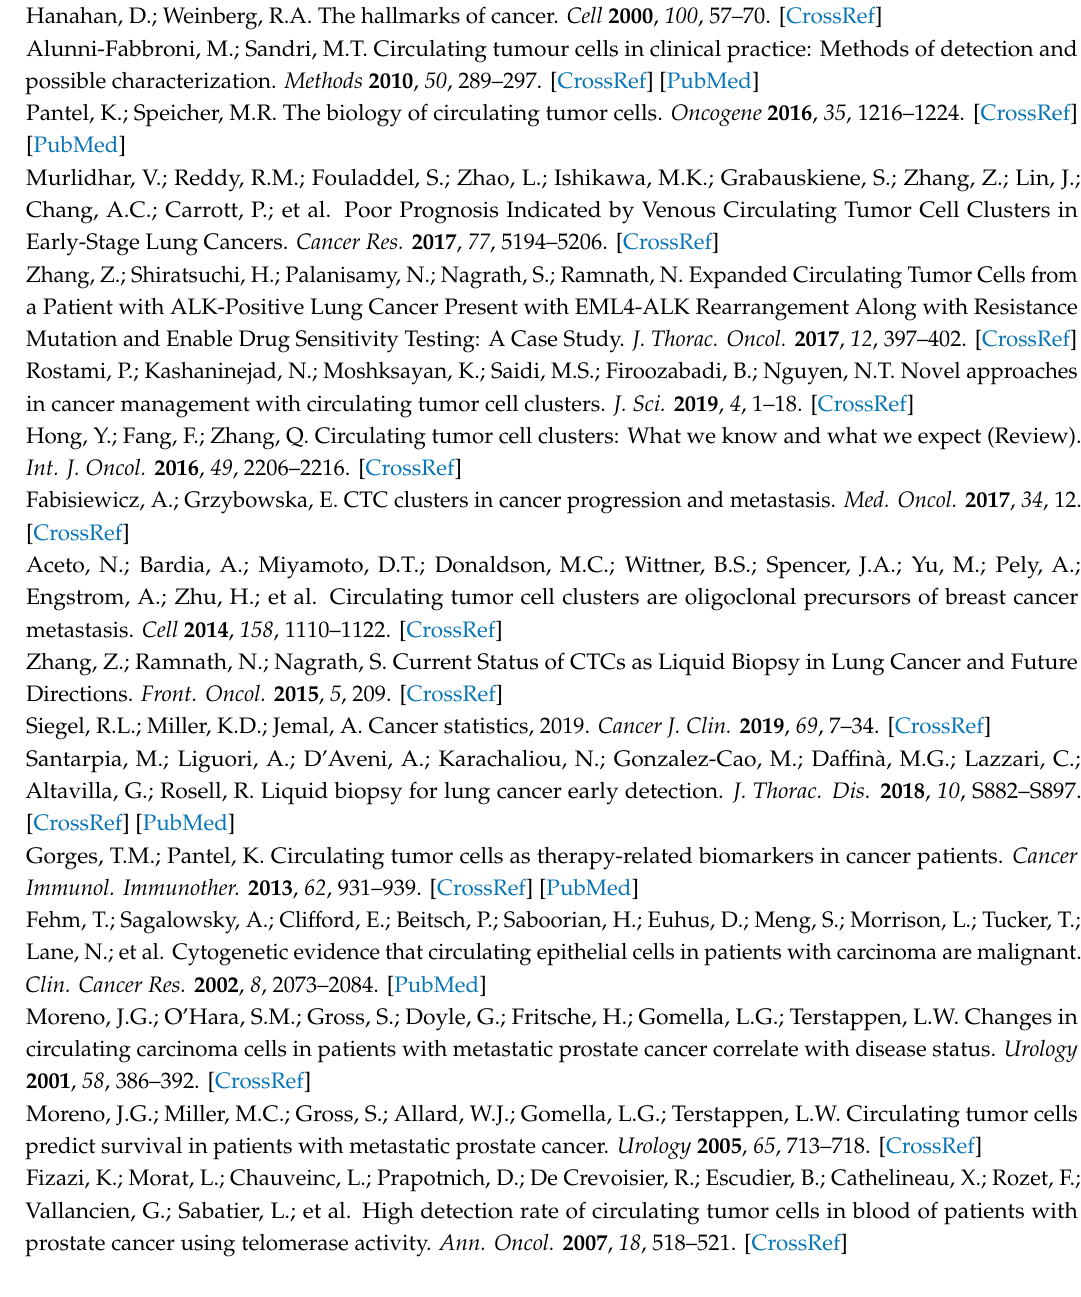
Table of Contents: Using a high-throughput, biomarker-independent inertial microfluidic device, Labyrinth, circulating tumor cells (CTCs) and CTC clusters were enriched from blood samples of patients with metastatic non-small-cell lung cancer (NSCLC). Heterogeneous CTCs subpopulations and CTC clusters were detected in 100% and 96% of patients